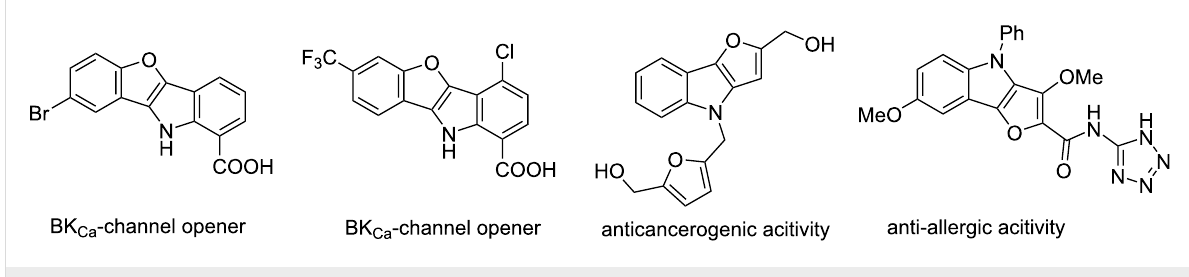
Figure 1: Pharmacologically relevant furoindoles.